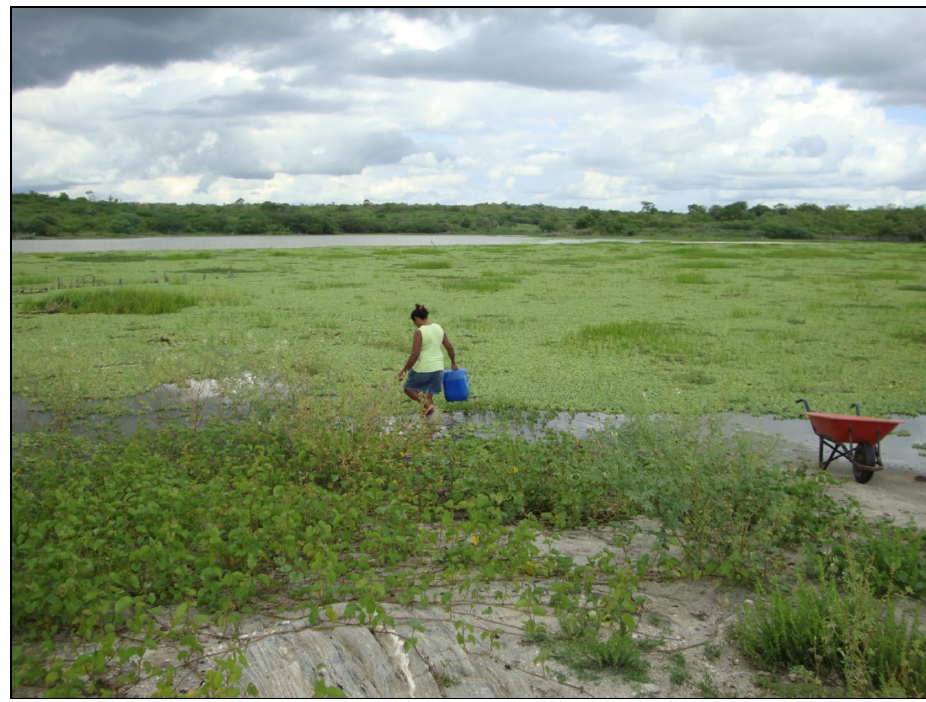
Figure 6. Example of reservoir in the Brazilian semiarid region with the occurrence terrestrial and aquatic vegetation: Paus Branco reservoir, Ceará, March 2011; HIDROSED files.